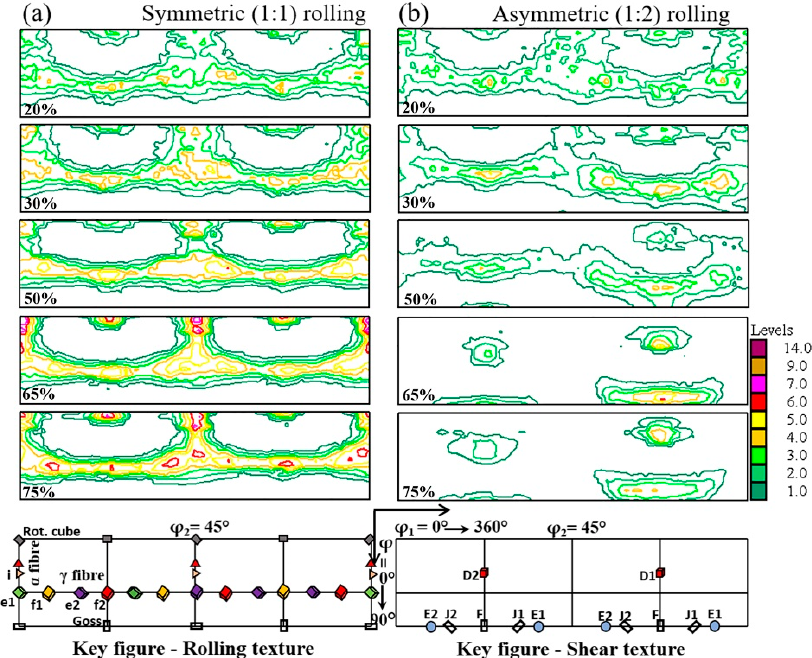
Figure 3. φ 2 = 45° sections of ODFs in mid thickness area for ( a ) symmetric (1:1) and ( b ) asymmetric (1:2) single pass rolling with a thickness reduction per pass (TRPP) in the range of 20–75%.